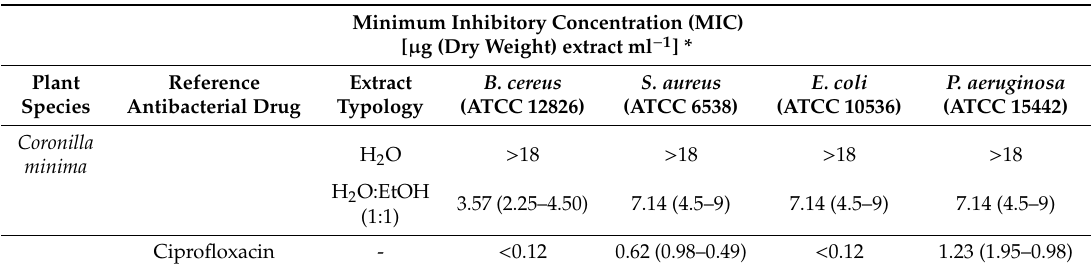
Table 5. Minimum inhibitory concentration (MIC) of plant extracts toward selected bacterial strains.